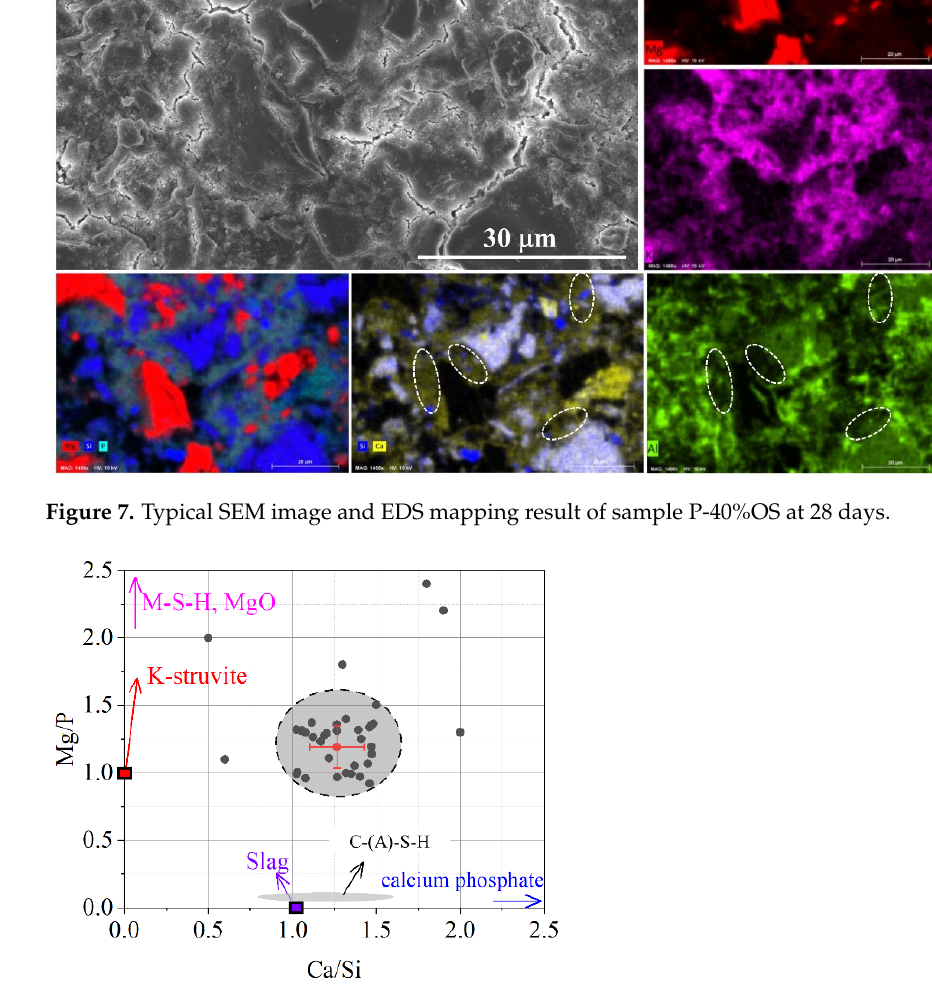
Figure 7. Typical SEM image and EDS mapping result of sample P ‐ 40%OS at 28 days.